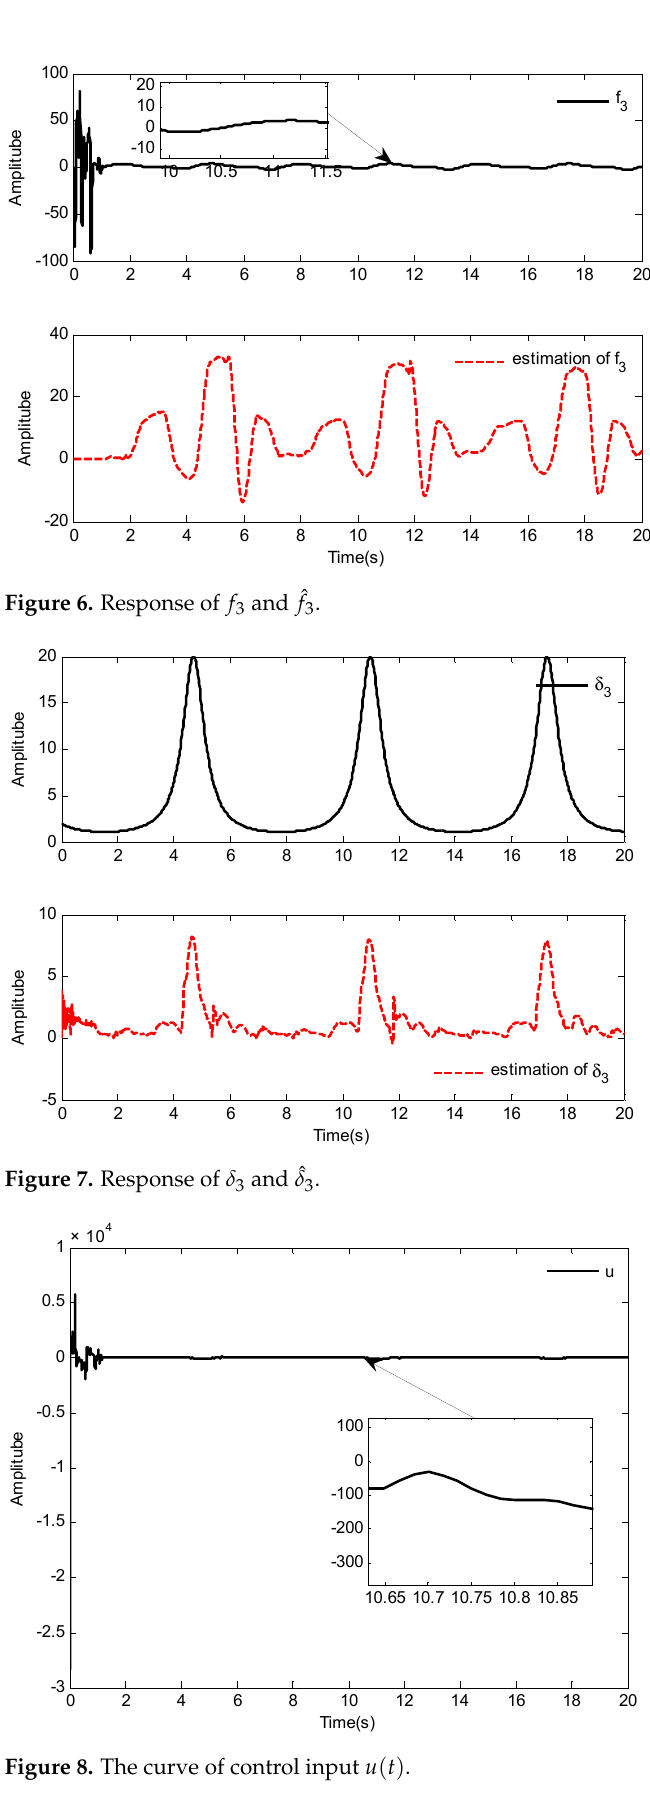
Figure 5. Response of